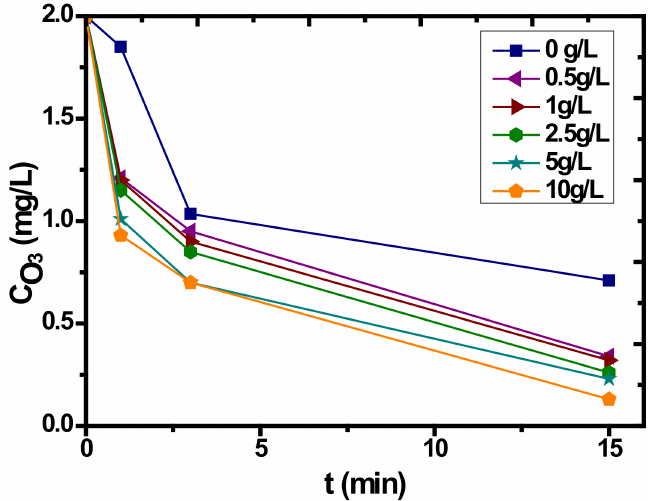
Figure 6. Influence of PET dosage in the decomposition of ozone during the heterogeneous catalytic ozonation of p‐CBA; experimental conditions: C O3 = 2 mg/L, C p‐CBA = 4 μΜ, pH = 7, T = 20 °C.